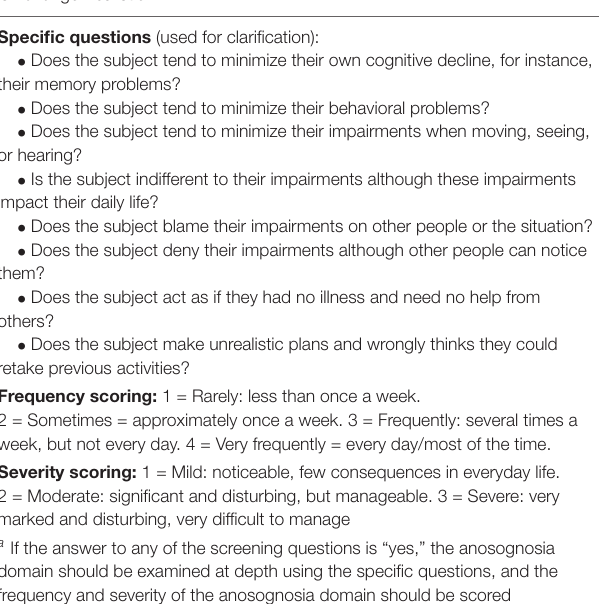
TABLE 1 | Anosognosia assessment in the behavioral dysexecutive syndrome inventory (Godefroy et al., 2010). Screening questions: Does the subject minimize or fail to recognize the limitations or difficulties that they have and the consequences of those limitations in daily life? Does the subject make unrealistic plans? Does the subject think that they can do the same things they used to do even when this is no longer